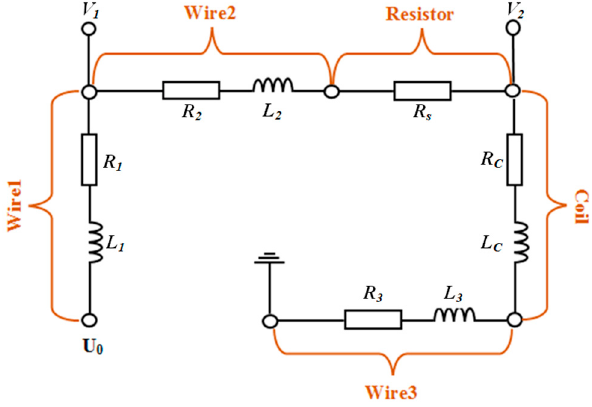
Figure 2. Equivalent circuit of measurement system.